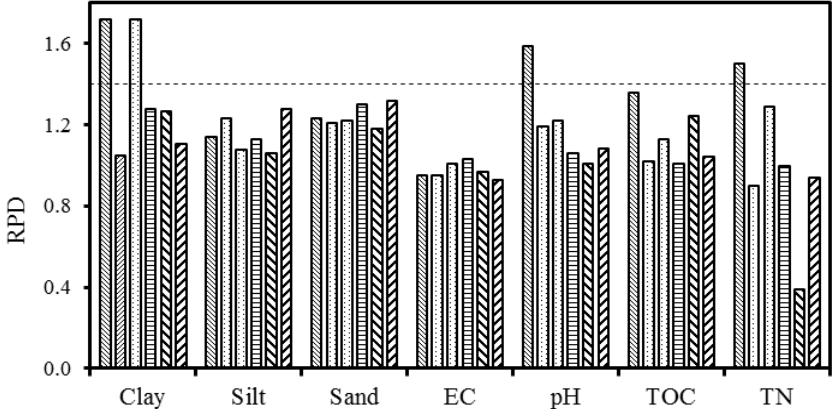
Figure 4. RPD statistic of individual and combined fields in 0–15 cm and 15–30 cm depths for the FSA method. Legend: = conventional field 0–15 cm depth, = conventional field 15–30 cm depth, = organic field 0–15 cm depth, = organic field 15–30 cm depth, = combined fields 0–15 cm depth and = combined fields 15–30 cm depth. Dashed line indicates the RPD value of 1.4, which is a threshold commonly used in chemometrics.